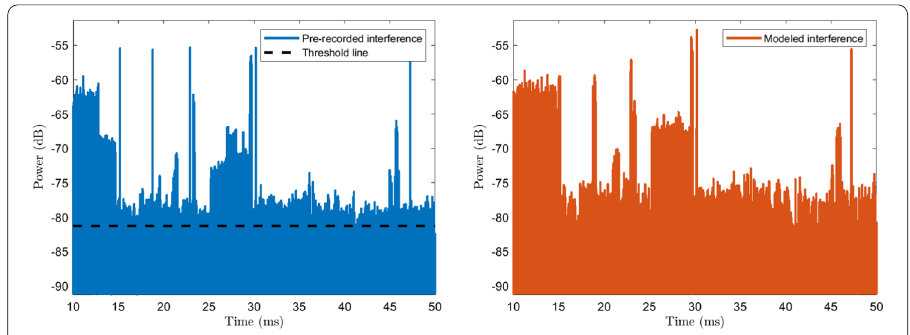
Fig. 10 Envelope power. Left: pre-recorded interference, right: IQ-based modeled